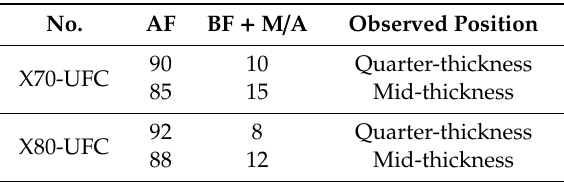
Table 2. Area fractions of microstructural constituents of X70 (25.4 mm) and X80 (22 mm) pipeline strips across the